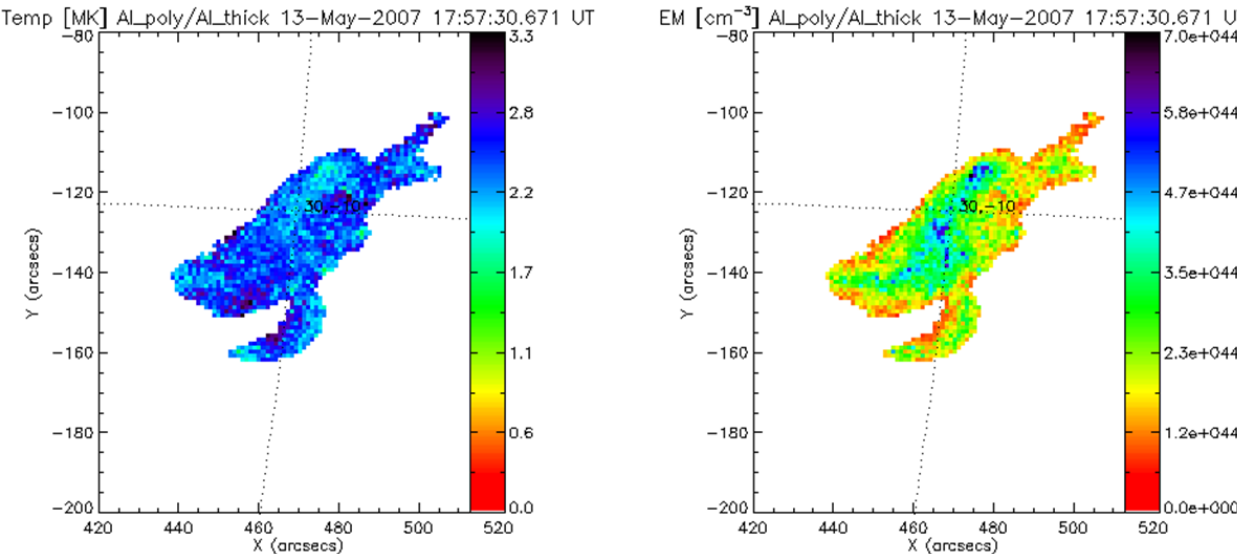
Fig. 2. Temperature and emission measure maps calculated from two filters ratio, Al poly/Al thick for the active region NOAA 0955 observed on 13 May 2007 at